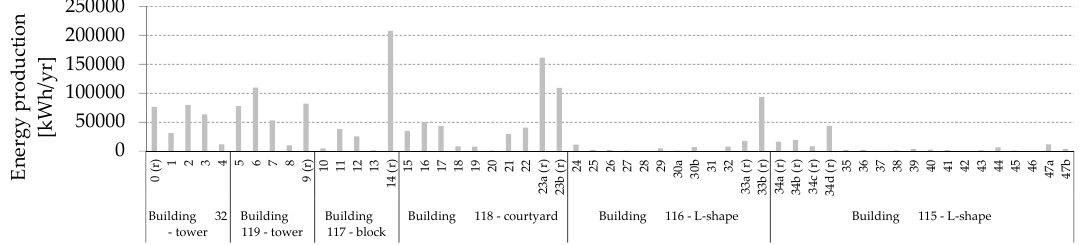
Figure 26. Solar energy generation on roofs (r) and façades in the critical area for feasibility study II. Table 13 . Energy coverage potential by solar technologies in the critical area for feasibility study II. Building Type